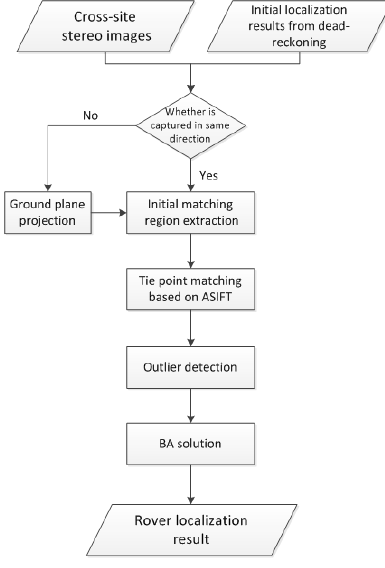
Figure 1. The workflow of the proposed rover localization